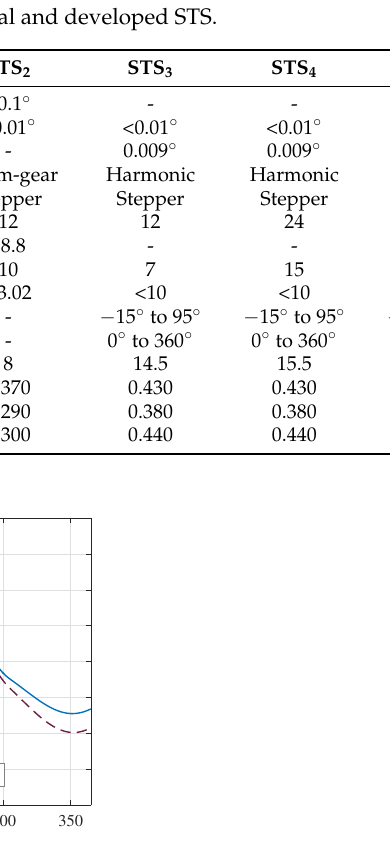
Figure 12. Yearly clear-sky insolation comparison between one-axis polar mount tracker and a two-axis tracker.